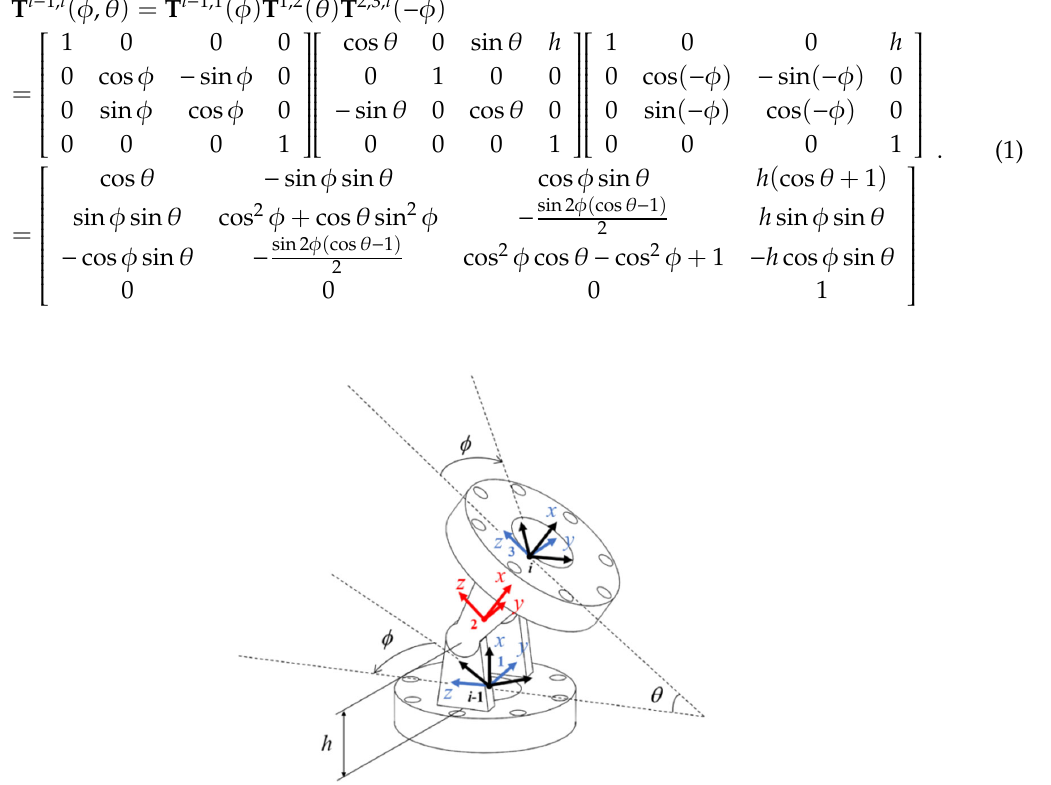
Figure 4. Diagram of a single ‐ joint section.